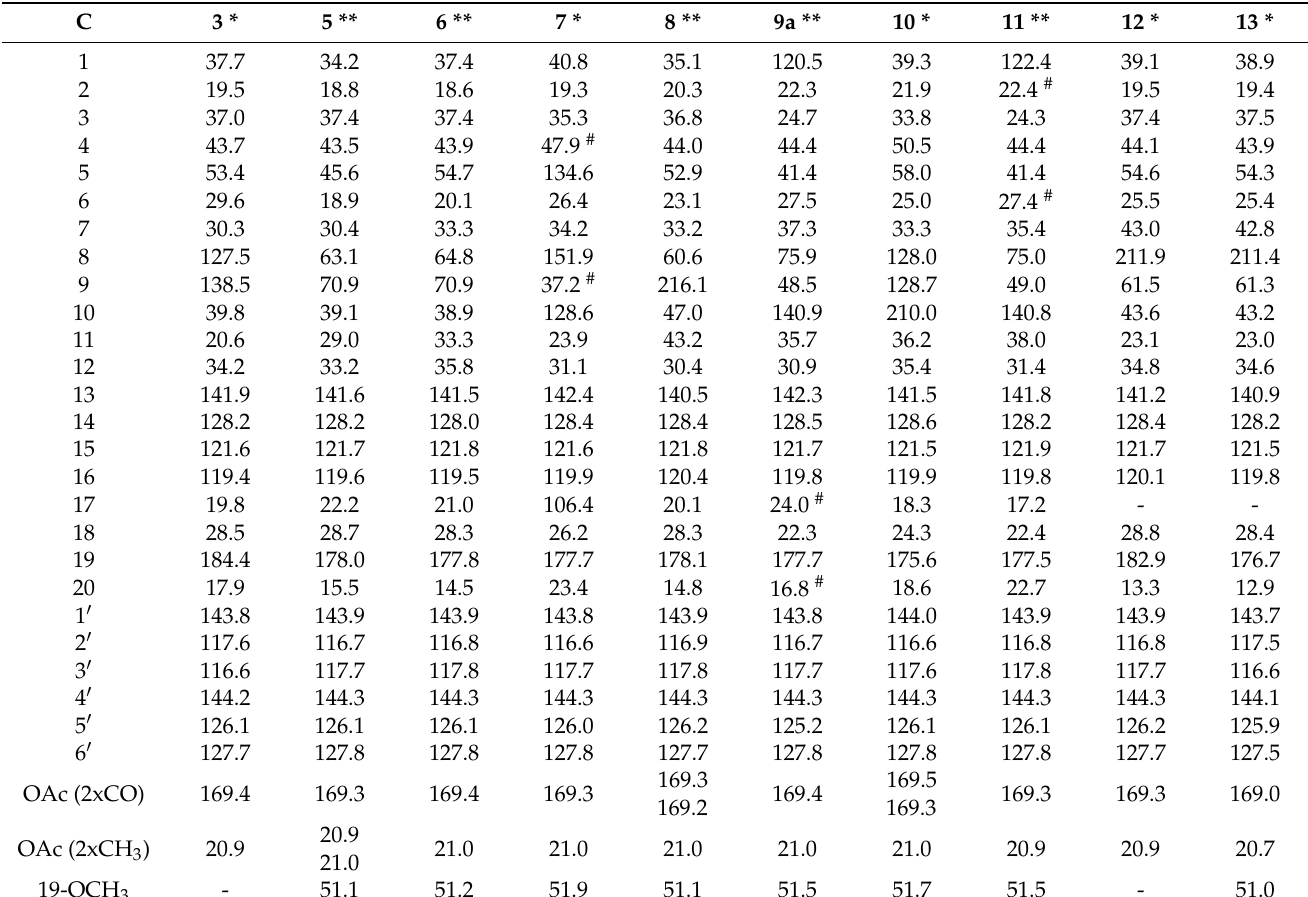
Table 3. 13 C-NMR data for compounds 3,5–13 ( δ ppm).